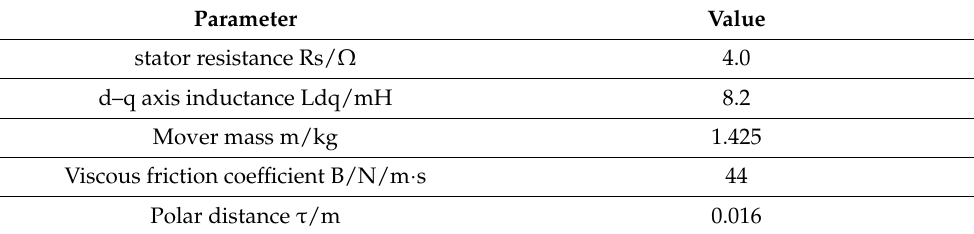
Table 1. Main parameters of the